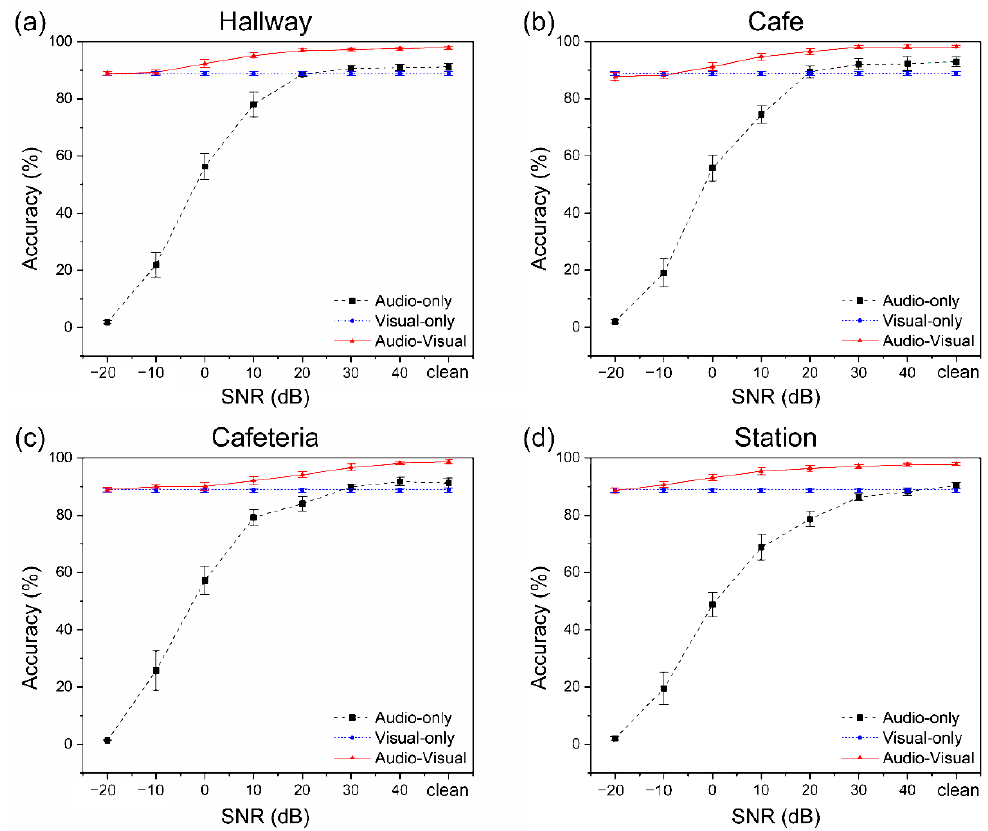
Figure 14. Standard variation of the identification accuracy rate across four noise situations. Standard deviation is shown by error bars. The audio recognition result is shown by the black (single-modal recognition) line, the visual recognition result is represented by the blue (single-modal recognition) line, and the audiovisual recognition result is represented by the red (multimodal recognition) line. The identification outcome in a true experimental setting is called clean SNR.